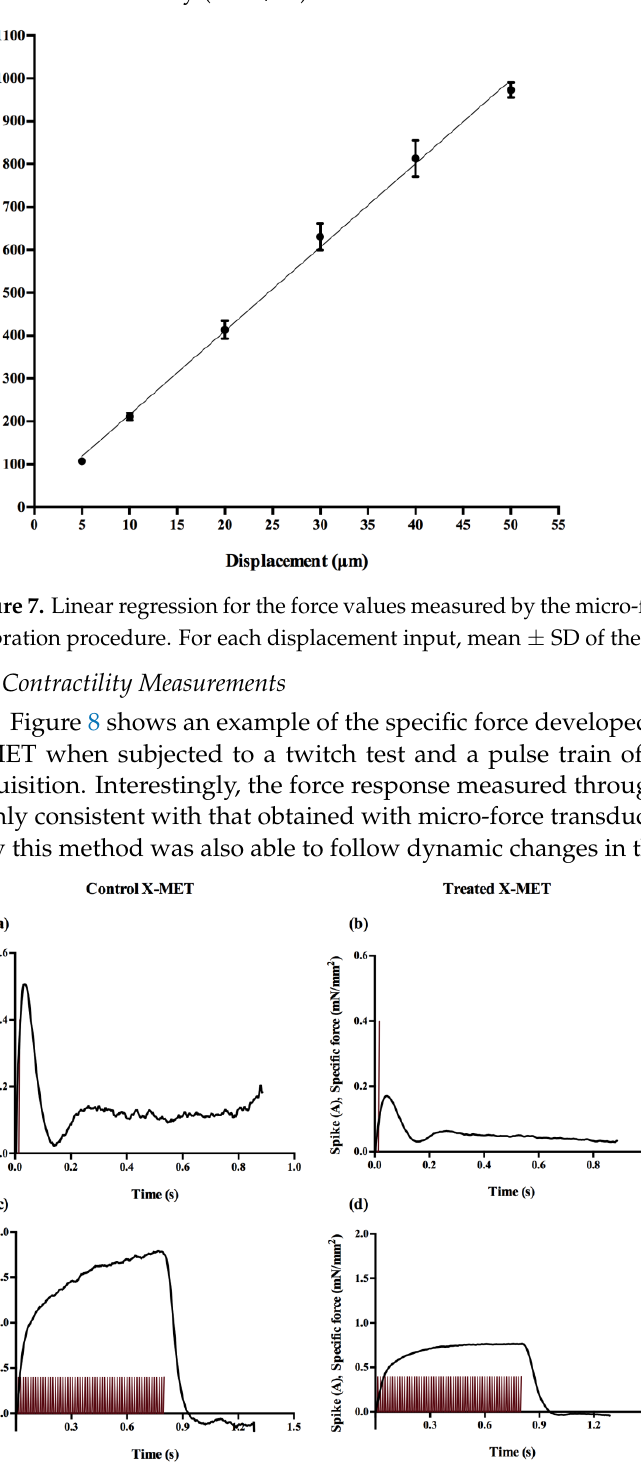
Figure 8. Example of the specific force developed by the X-MET on the first day of the experimental tests. Specific force (black) developed when subjecting the tissues to the twitch test (current spikes are in red) for control ( a ) and treated ( b ) X-MET and specific force developed during the 80 Hz pulse train (current spikes are in red) for control ( c ) and treated ( d ) X-MET.